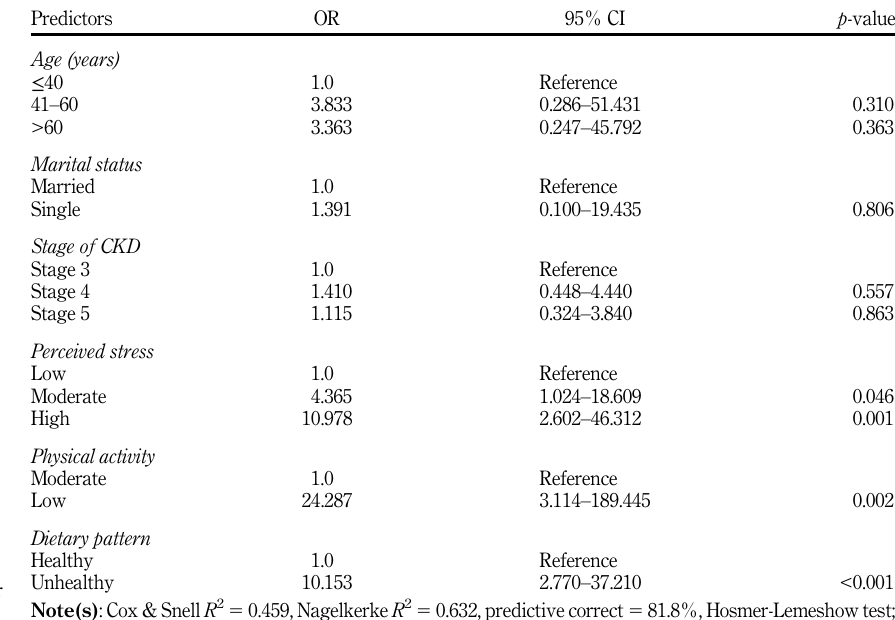
Table II. ORs and 95% CIs for uncontrolled blood